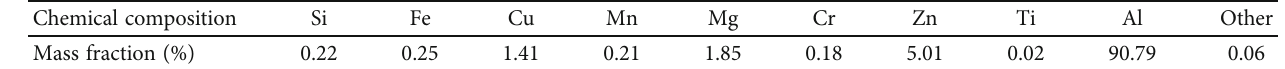
Table 2: 7A04 aluminum alloy chemical composition.